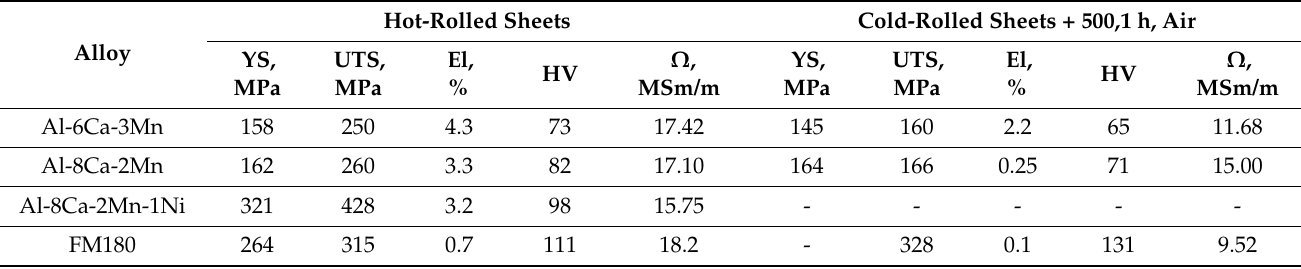
Table 6. Physical and mechanical properties of the hot-rolled and cold-rolled sheets. Hot-Rolled Alloy